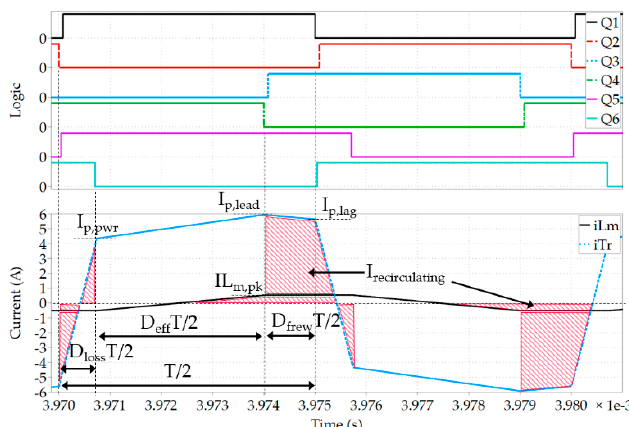
Figure 2. Primary side current and PWM control signals of a simplified model of a PSFB converter.